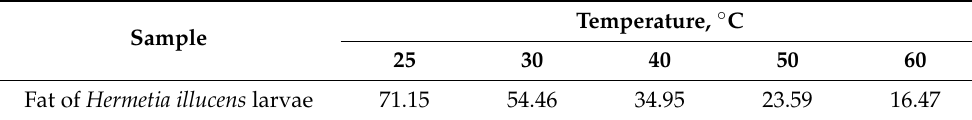
Figure 2. BSFLF properties: ( a ) oxidative stability curve of the BSFLF sample; ( b ) dependence of viscosity of the BSFLF sample on temperature and time. Table 3. Viscosity of fat as a function of temperature,